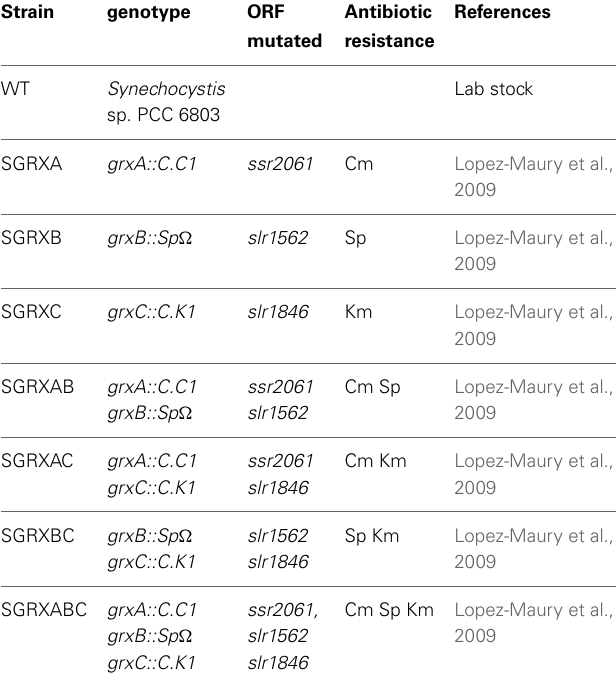
Table 1 | Strains used in this